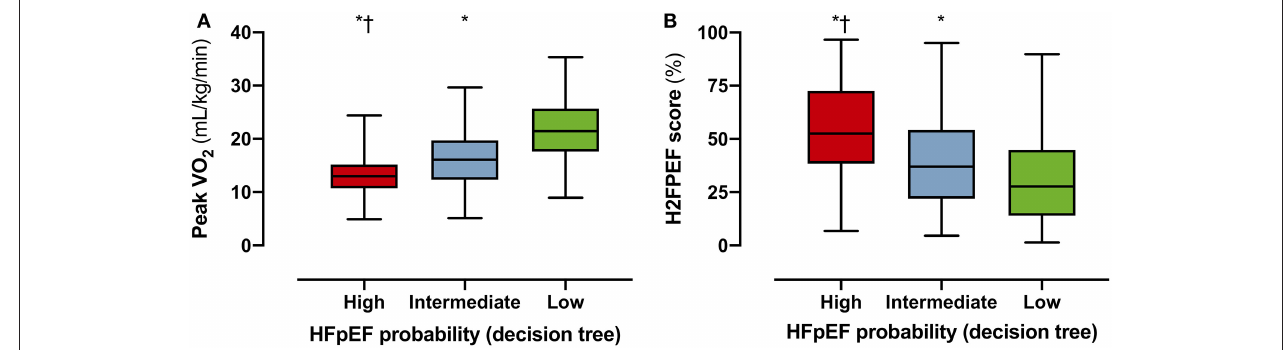
FIGURE 4 | Performance of decision tree in the DST cohort. To evaluate the performance of the decision tree ( Figure 3 ), the probability of HFpEF according to the decision tree (high/intermediate/low) was compared to surrogate HFpEF indicators peak VO 2 (A) and logistic H2FPEF score (B) , which calculates the probability of elevated exPAWP in percentage through clinical and echocardiographic parameters (17). Multiplicity-corrected P- values from Kruskal-Wallis test. HFpEF, heart failure with preserved ejection fraction; Peak VO 2 , peak oxygen uptake, * p < 0.001 compared to low; † p < 0.001 compared to